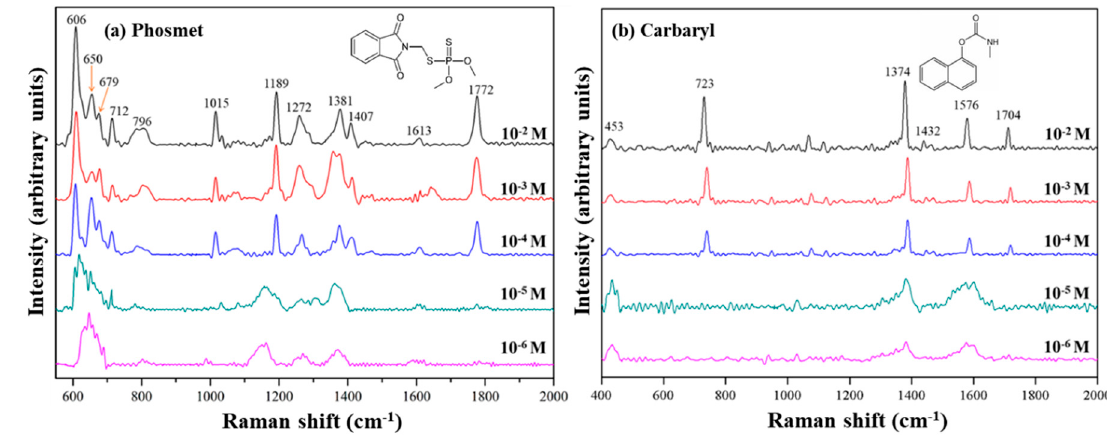
Figure 4. SERS spectra of standard solutions of ( a ) phosmet and ( b ) carbaryl at varying concentrations on Au NPs (3.0)/ p ZrO 2 .